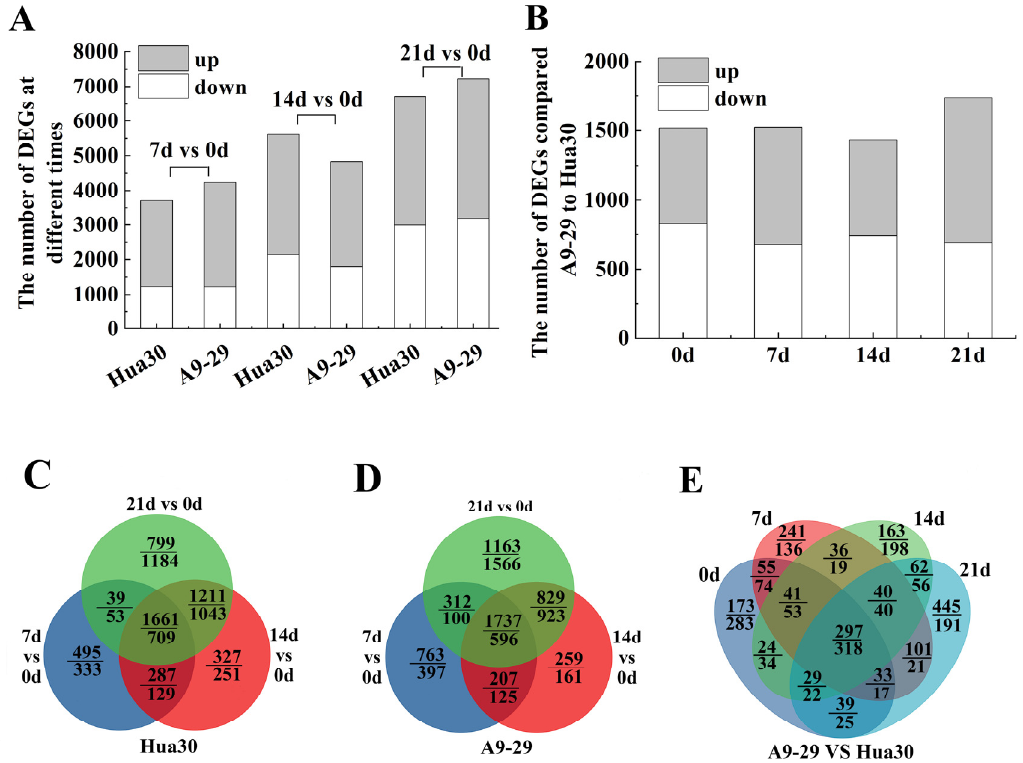
Figure 2. Venn diagrams of DEGs between A9 ‐ 29 and Hua30 under low ‐ N conditions. ( A ) Summary of DEGs in Hua30 and A9 ‐ 29 at each time point compared to those at 0d. ( B ) Summary of DEGs in A9 ‐ 29 compared to Hua30. ( C ) The numbers of up ‐ and down ‐ regulated DEGs in Hua30 under low ‐ N stress. ( D ) The numbers of up ‐ and downregulated DEGs in A9 ‐ 29 under low ‐ N stress. ( E ) The numbers of up ‐ and downregulated DEGs in A9 ‐ 29 compared to Hua30. The numbers above the horizontal line indicate the number of upregulated DEGs and those below the horizontal line represent the number of downregulated DEGs.